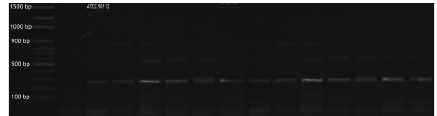
Figure 3: Agarose gel electropheresis of LAC1 gene specific PCR of all the examined C. neoformans isolates with production of amplicons of 250, 760, and 880 bp, marker 100bp DNA plus ladder (Jena